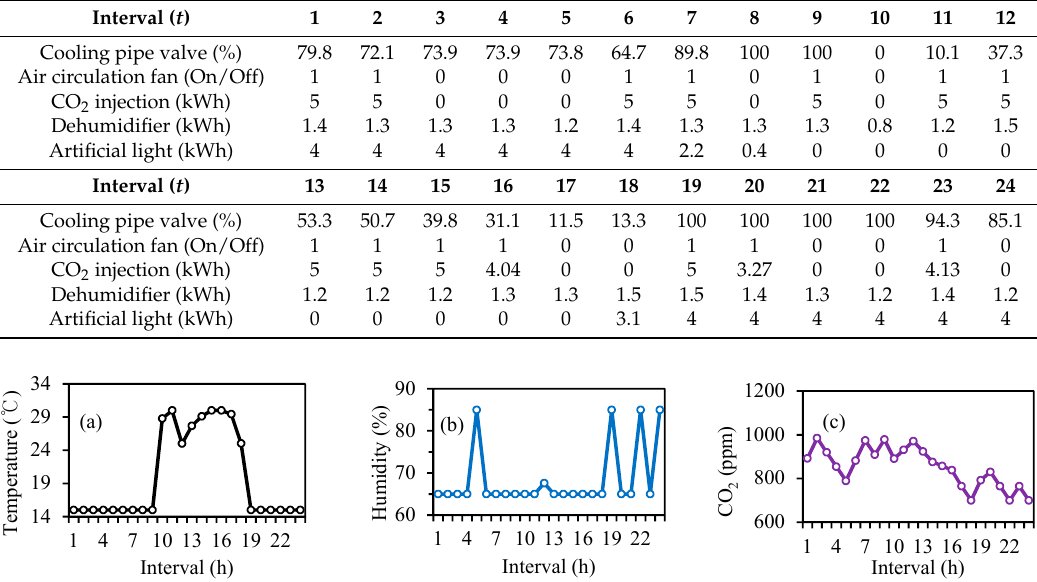
Figure 11. Environmental control of greenhouse in summer season: ( a ) temperature; ( b ) humidity; and ( c ) CO 2 concentration.